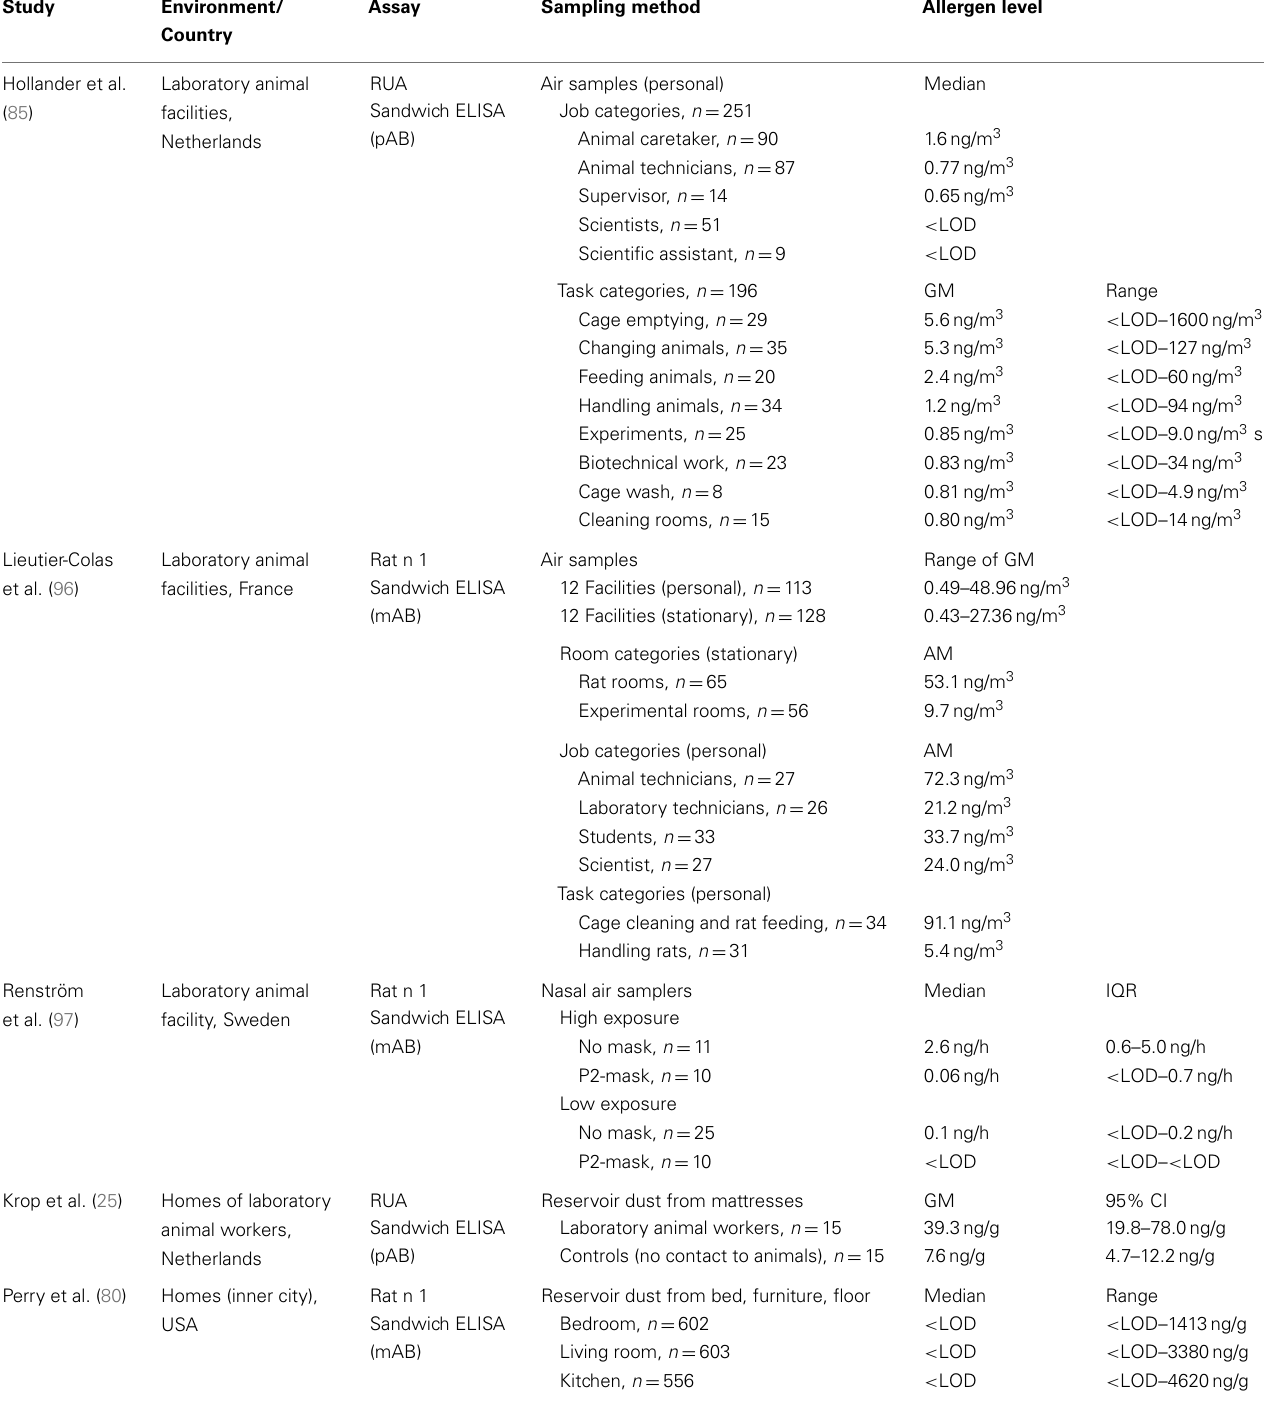
Table 4 | Studies related to exposure assessment to rat